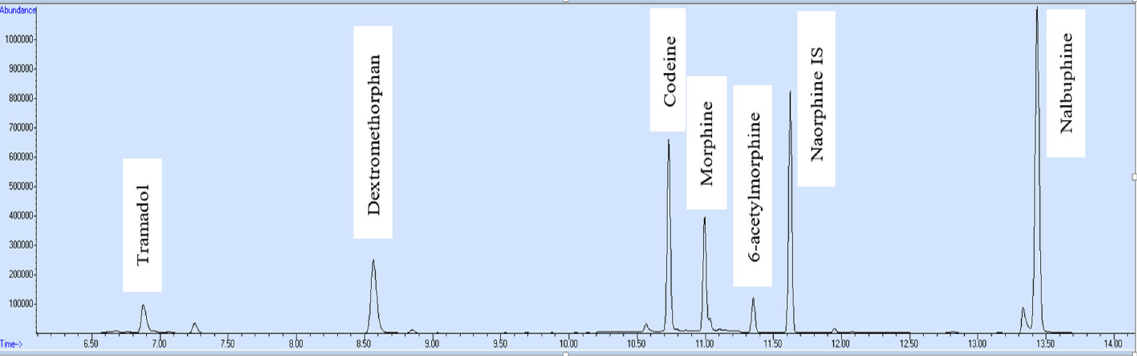
Table 2. Target opioids with their respective SIM ion.